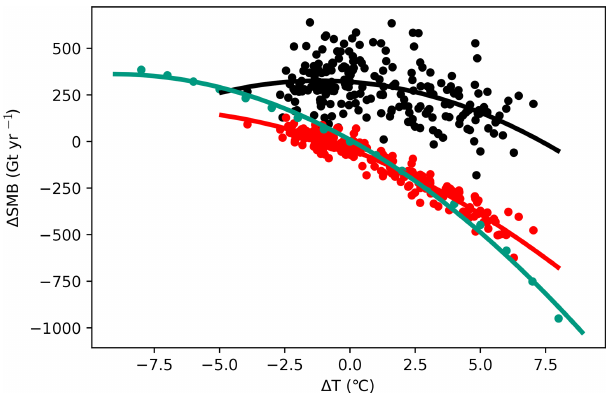
Figure 13. Change in surface mass balance as a function of anoma- lous annual average temperature over Greenland. Colours represent a spatially uniform temperature anomaly (green), a temperature pat- tern derived from a particular simulation year of a climate model (red), and the same temperature anomaly accompanied with the cor- responding precipitation anomaly (black). Curves represent a least- squares regression of order